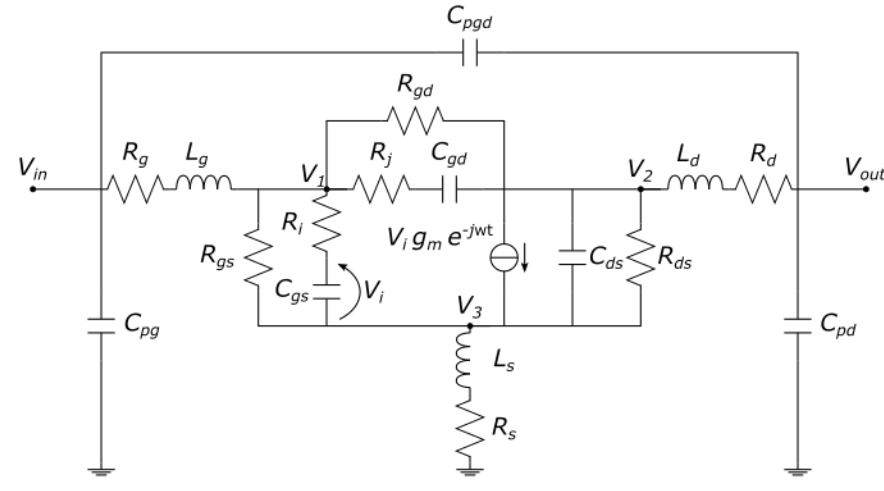
Figure 3. Equivalent circuit chosen for small signal model